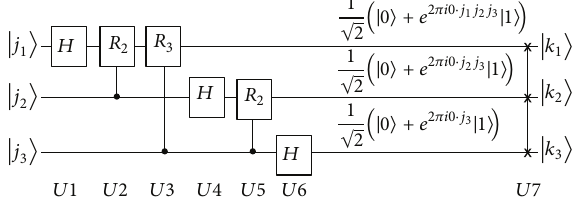
Figure 8: Quantum circuit for 3-qubit QFT.